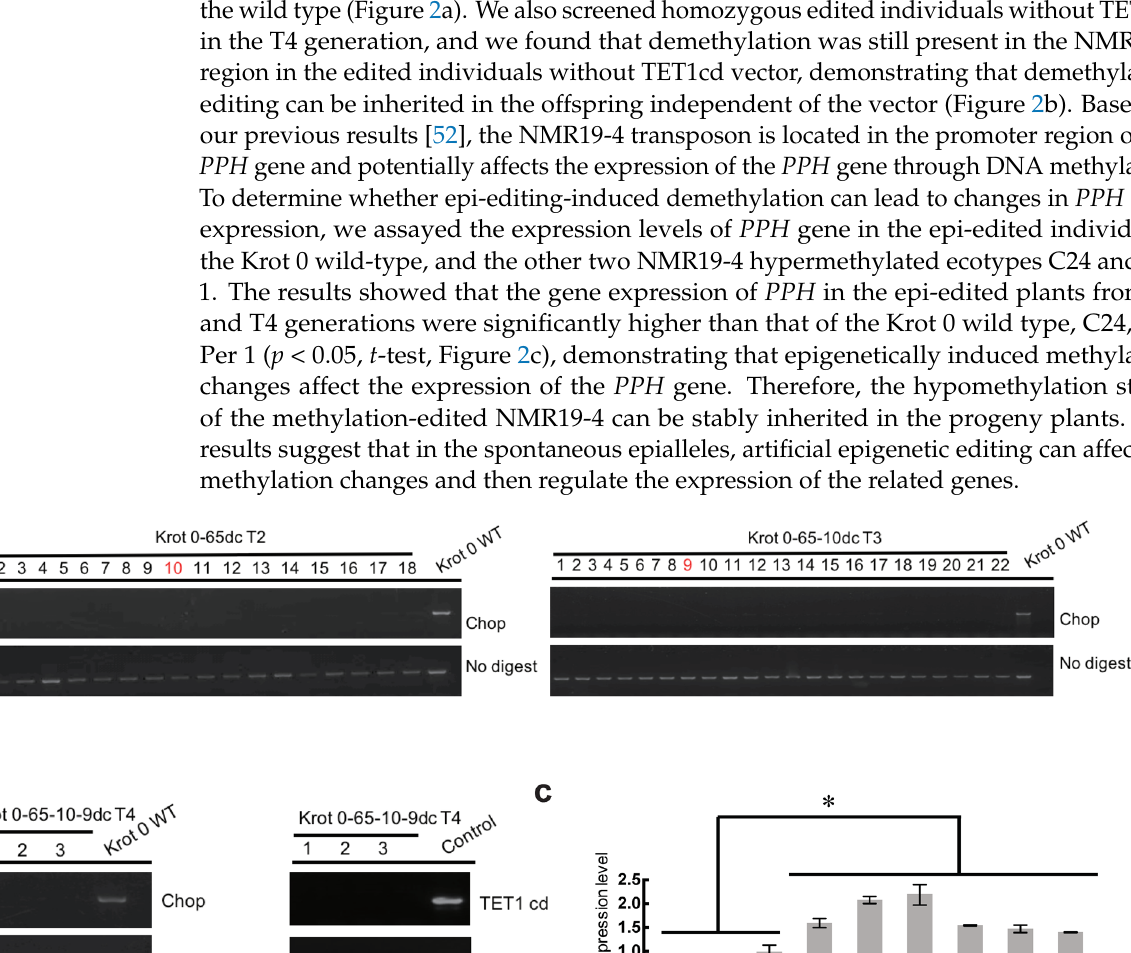
5 of 16 Green filled circles indicate hypermethylation and red open circles indicate hypomethylation. ( c ) Chop-PCR analysis of the methylation level of NMR19-4 detected in transformation Arabidopsis T1 generation. The number marked in red represents the line we use in our subsequent experi- ments. 2.2. Inheritance of the Epimutation in Krot 0-65dc Whether the epi-edited alleles can be stably inherited through multiple generations is an important concern for epigenetic editing. To investigate the inheritance in Krot